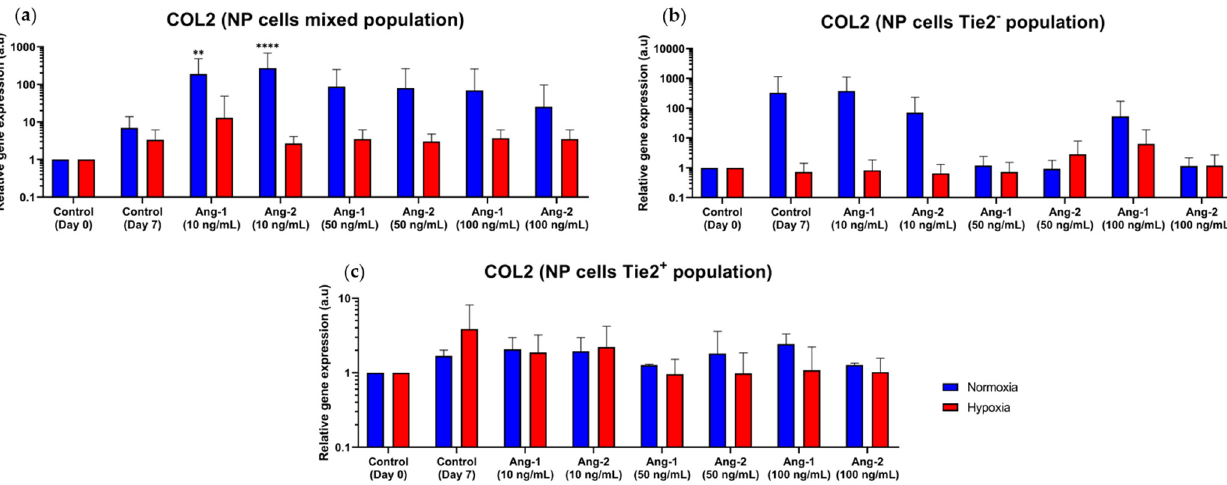
Figure 4. Relative gene expression of the three NP cells populations, comparing the effect of Ang1/2 at different concentrations in normoxia and hypoxia on the COL2 gene expression. The control (Day 0) samples were used as reference (set at 1). Ang-1 and Ang-2 were administrated in three concentrations: 10, 50 and 100 ng/mL. ( a ) COL2 relative gene expression of NP cells mixed population; ( b ) COL2 relative gene expression of NP cells Tie2 − population; ( c ) COL2 relative gene expression of NP cells Tie2 + population. Bars represent mean ± SD. A p -value < 0.05 was considered significant. Asterisks within figures denote the degree of statistical relevance observed: ** < 0.01; **** < 0.0001.